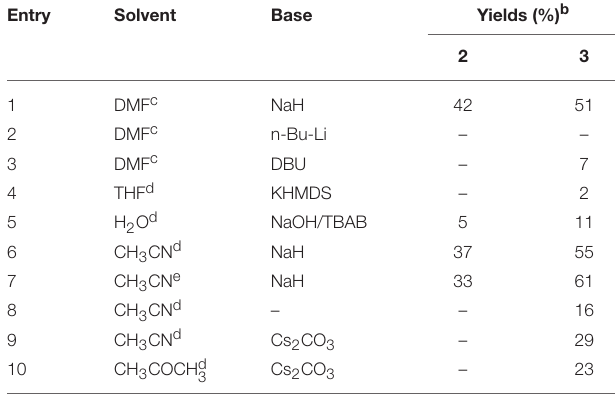
TABLE 2 | Optimization of the conditions for the reaction of 1 with piperidine a